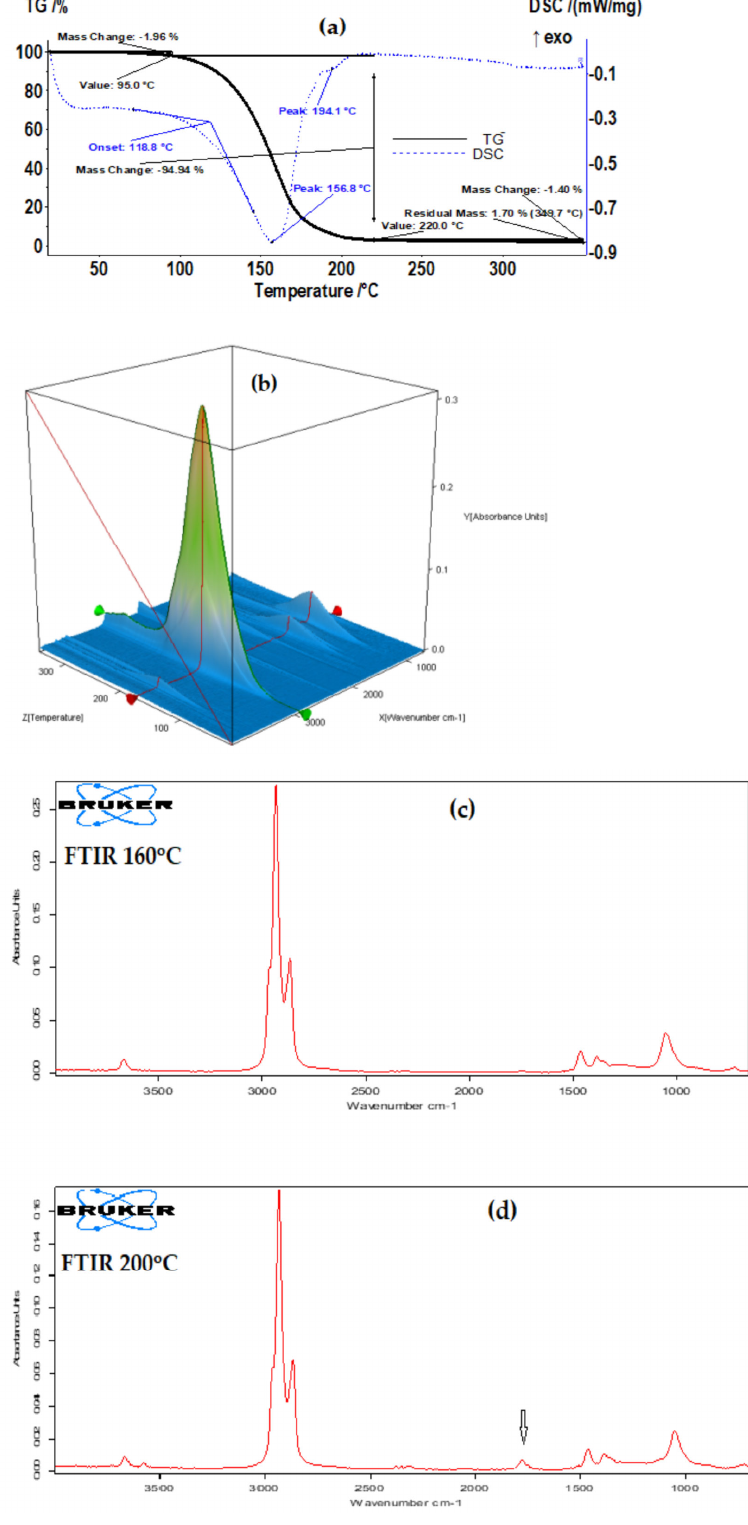
Figure 8. The thermal ( a ) and spectral ( b – d ) characteristics of membrane